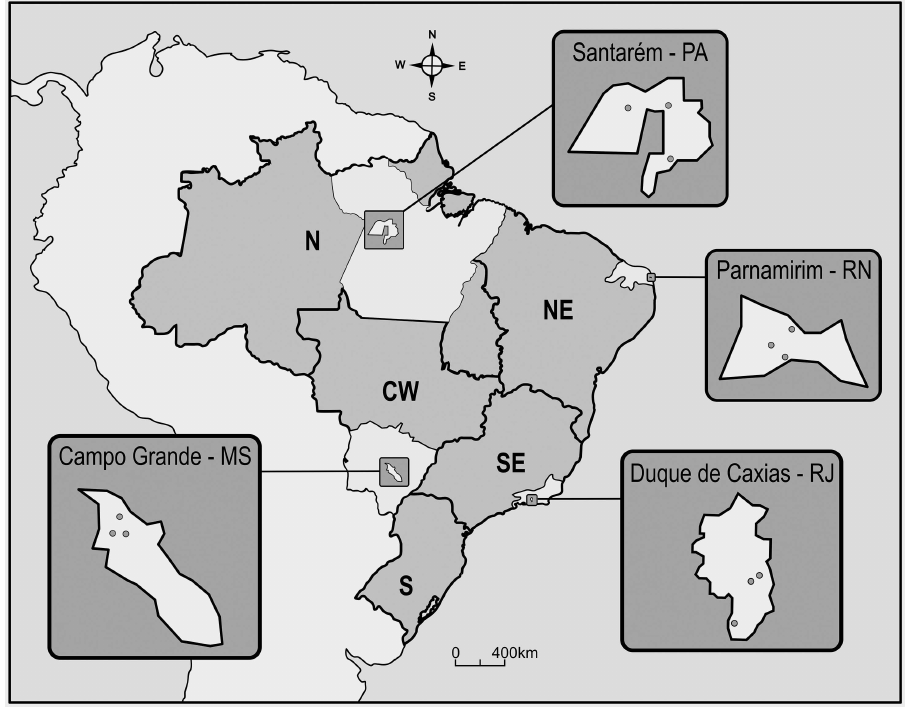
Fig 1. Map of Brazil showing the location of the four municipalities evaluated. In the course of one year, in each municipality, Ae . aegypti eggs were gathered in the field monthly, in three 1 km 2 areas, as indicated by grey circles. Letters beside city names account for the respective States: Santare´m—Para´ (PA), Parnamirim—Rio Grande do Norte (RN), Duque de Caxias—Rio de Janeiro (RJ) and Campo Grande—Mato Grosso do Sul (MS). References to the different Brazilian Regions are placed directly on the map: N—North, NE—Northeast, SE—Southeast, S—South, CW—Central-West.